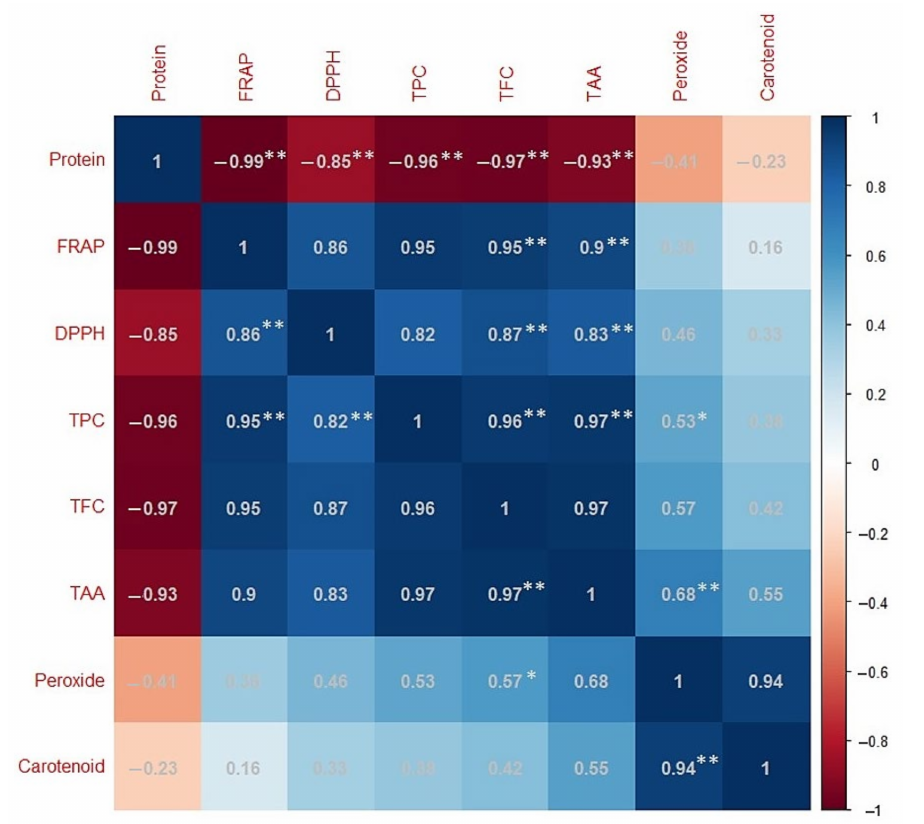
Figure 5. Correlation matrix of results obtained from data on eight metabolites for lentil samples differing in terms of seed-coat color. Each square indicates the Pearson’s correlation coefficient for a pair of metabolites, and the value for the correlation coefficient is represented by the intensity of the blue or red color as indicated on the color scale. Correlation is significant at the (**) p ≤ 0.01 and (*) p ≤ 0.05